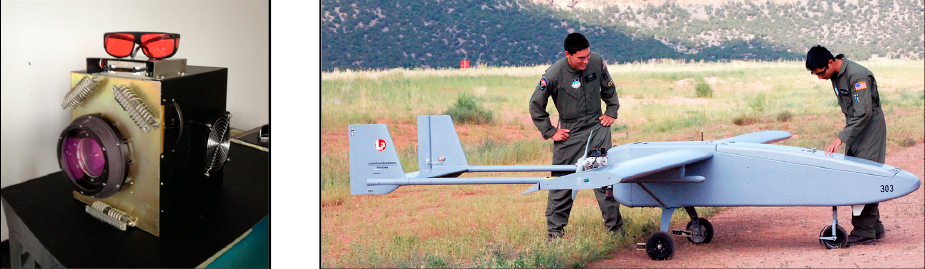
Figure 4. NASA Mini-ATM (Airborne Topographic Mapper) and its designated host aircraft, the Viking 300 micro-UAV.